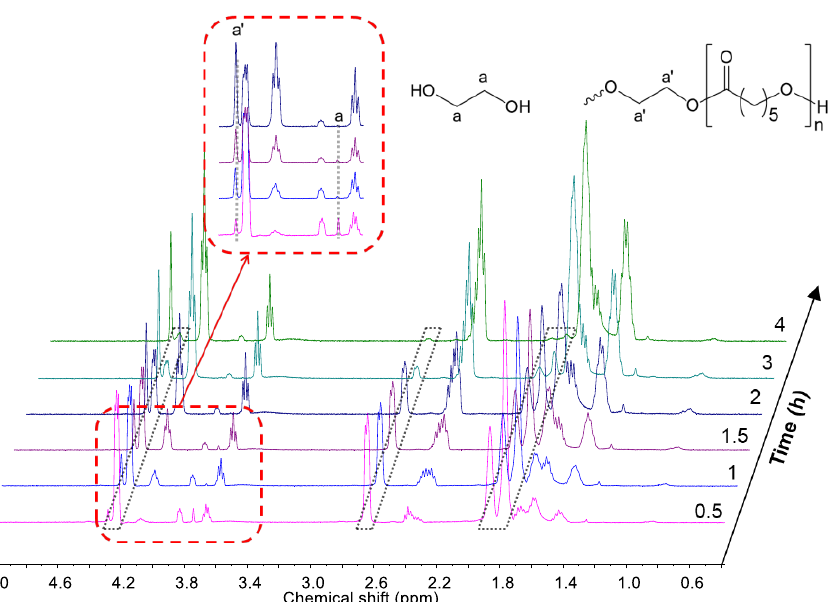
Figure 3. 1 H NMR (400 MHz, CDCl 3 ) spectra of the PCL collected at different intervals. Conditions: DMC-IBN = 10 mg ([ Zn ] 0 = 30 × mM), [ CL ] 0 = 9 M, [ CL ] 0 /[ EG ] 0 = 10, T p = 160 °C. Dash lines denote the monomer signals.